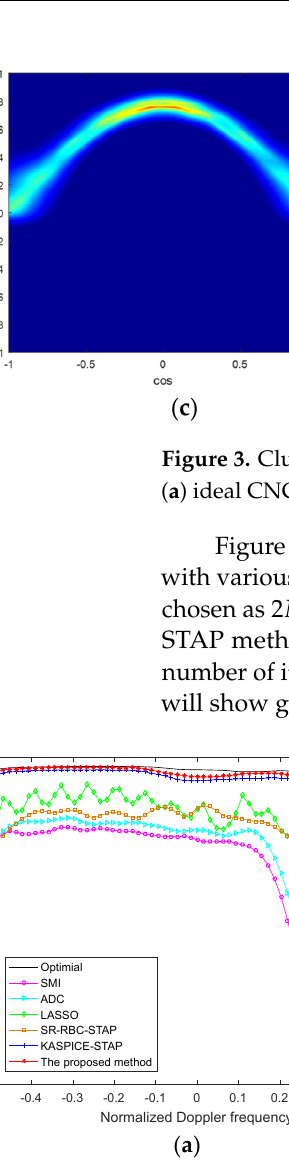
Figure 4. The IF versus normalized Doppler frequency with different methods in different range gates ( a ) the 300th range gate; ( b ) the 500th range gate.